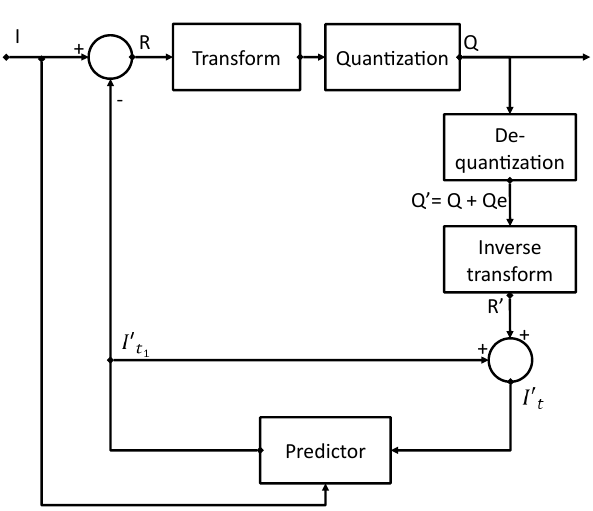
Figure 1. Differential pulse code modulation.